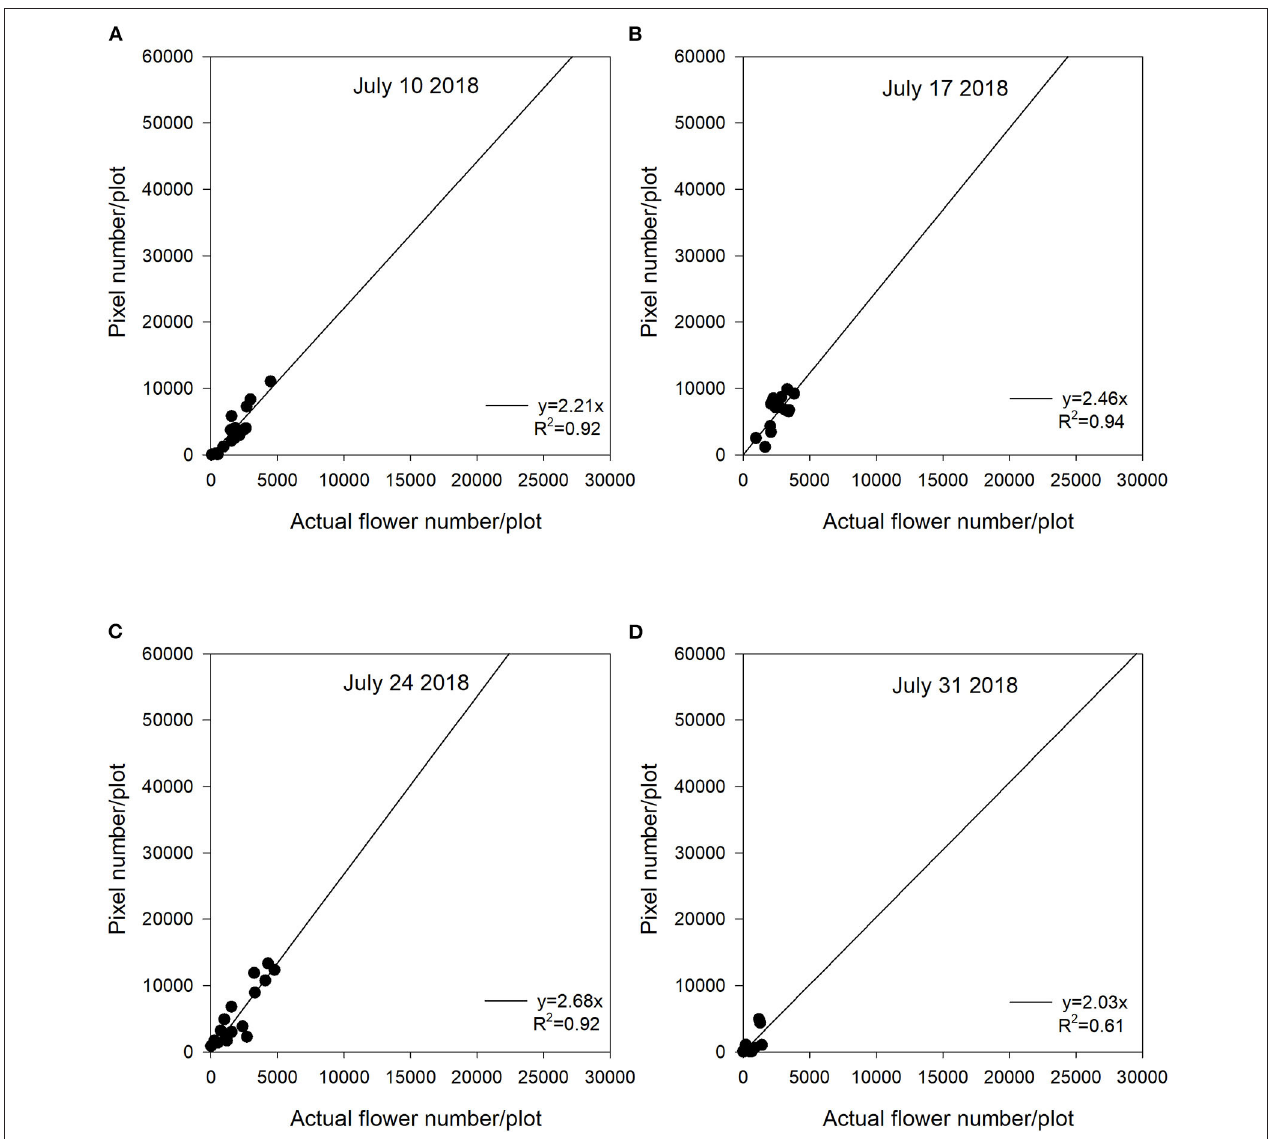
FIGURE 5 | The relationship between actual flower numbers per plot and pixel numbers extracted from aerial images during the flowering stage at Saskatoon, SK, Canada in 2018. Actual flower numbers per plot were manually measured. Pixel number per plot was detected by the thresholding method. (A) Regression equation for July 10, 2018: y = 2.21x, R 2 = 0.92. (B) Regression equation for July 17, 2018: y = 2.46x, R 2 = 0.94. (C) Regression equation for July 24, 2018: y = 2.68x, R 2 = 0.92. (D) Regression equation for July 31, 2018: y = 2.03x, R 2 = 0.61.